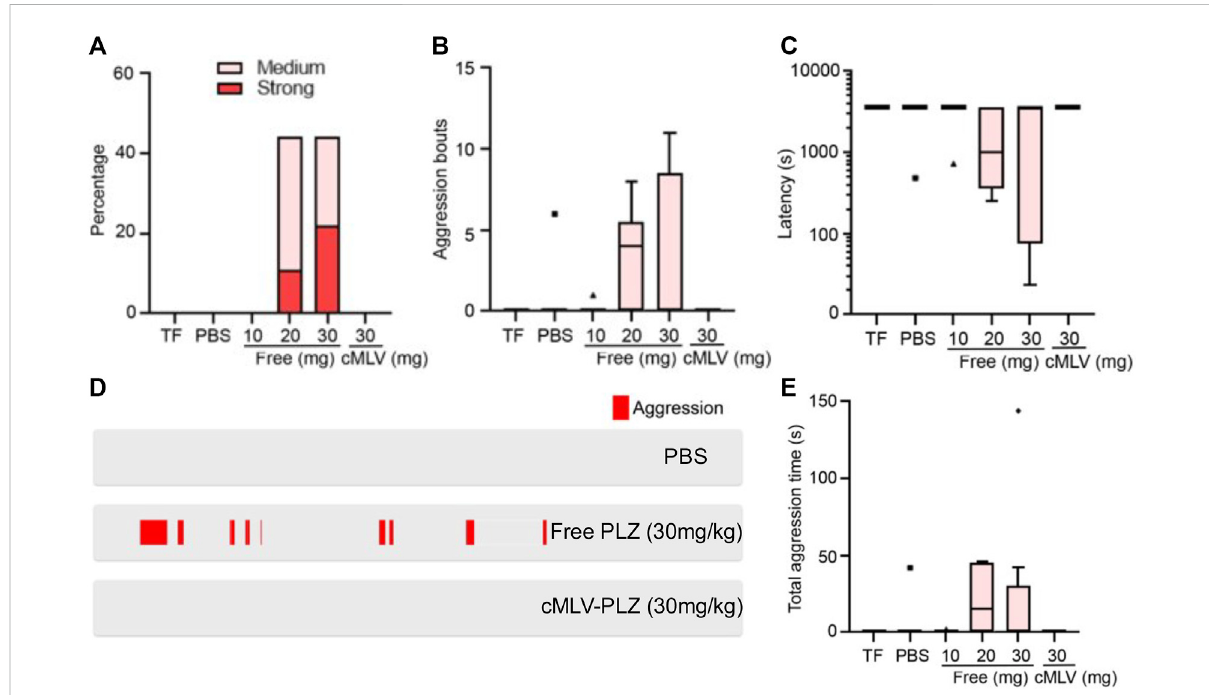
FIGURE 2 Resident-intruder aggression tests demonstrate decreased aggression in cMLV-PLZ mice. Effects of nanoformulation on MAOI-instigated aggression were investigated in tumor-bearing mice treated with either free or cMLV-formulated phenelzine (TF = Tumor Free; Free-PLZ or cMLV- PLZ; i. v, q3d). N = 5. mg: 30 mg/kg. Mice were treated with indicated does of phenelzine for 2 weeks, followed by behavioral analysis. Mouse aggression levels were recorded using a resident-intruder aggression test. (A) Percentage of animals showing medium to strong aggression upon intruder introduction. (B) Quanti fi cation of aggression bouts per trial across different conditions. (C) Quanti fi cation of latency to the onset